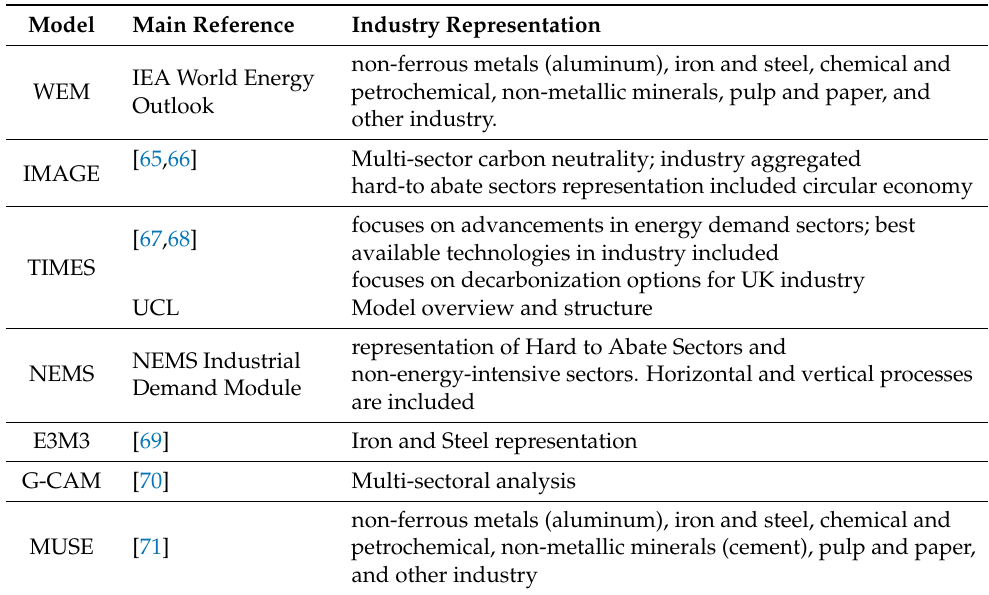
Table A1. Review of the industry sector in energy models. None of them includes the cluster representation.